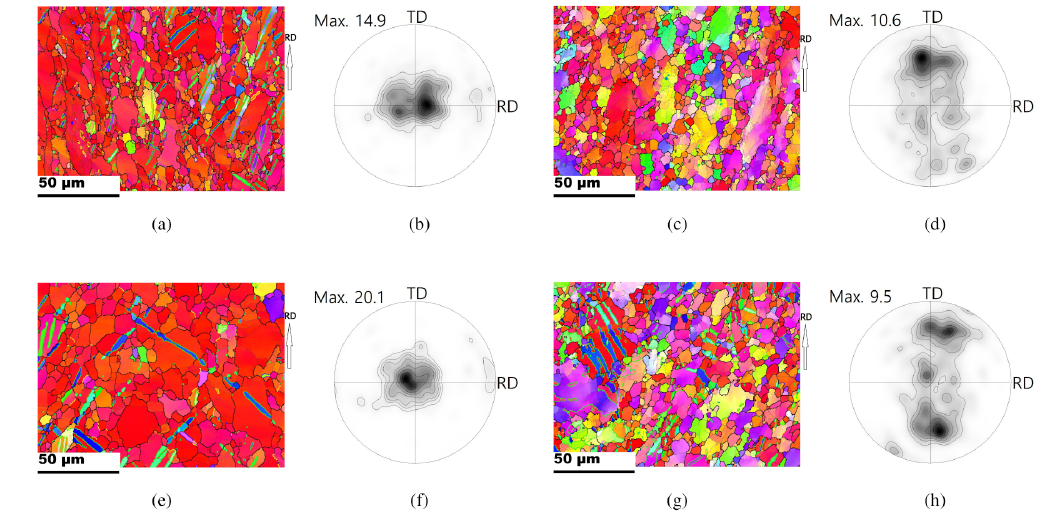
Figure 13. IPF maps and computed 0001 PFs of Part1, and Part3 regions of drawn cups. The punch speed and working temperature were 50mm/min and 350 ◦ C, respectively. Contours: 1, 2, 3, 5, 7, 10, 15, 20. TRC sheets: ( a ) Part 1, and ( b ) Part 3 for IPFs; ( c ) Part 1, and ( d ) Part 3 for PFs. IC sheets: ( e ) Part 1, and ( f ) Part 3 for IPFs; ( g ) Part 1, and ( h ) Part 3 for